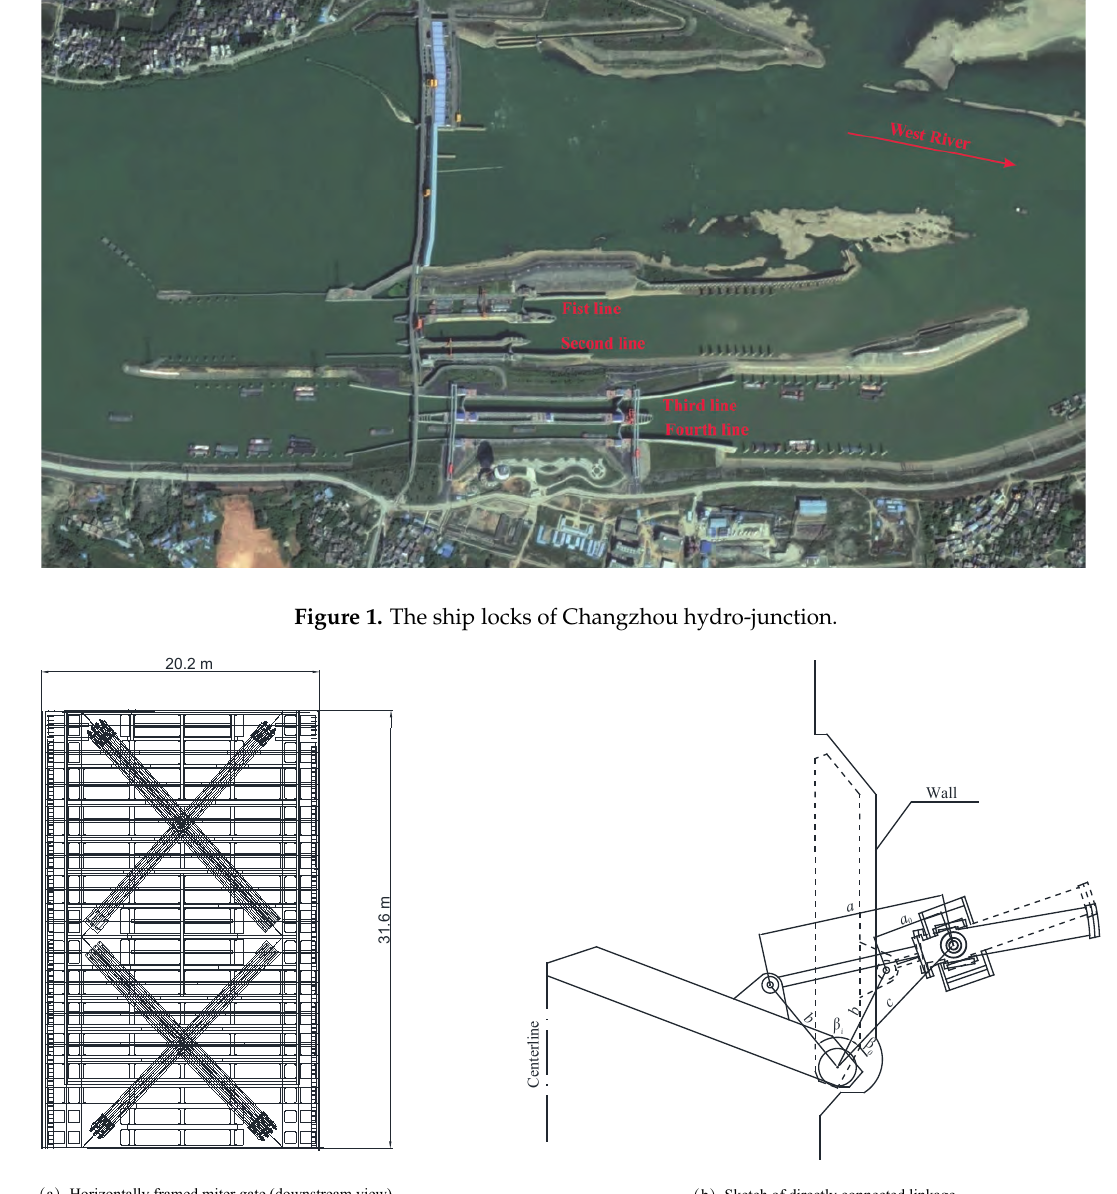
Figure 2. Typical miter gate leaf (downstream elevation) and connected